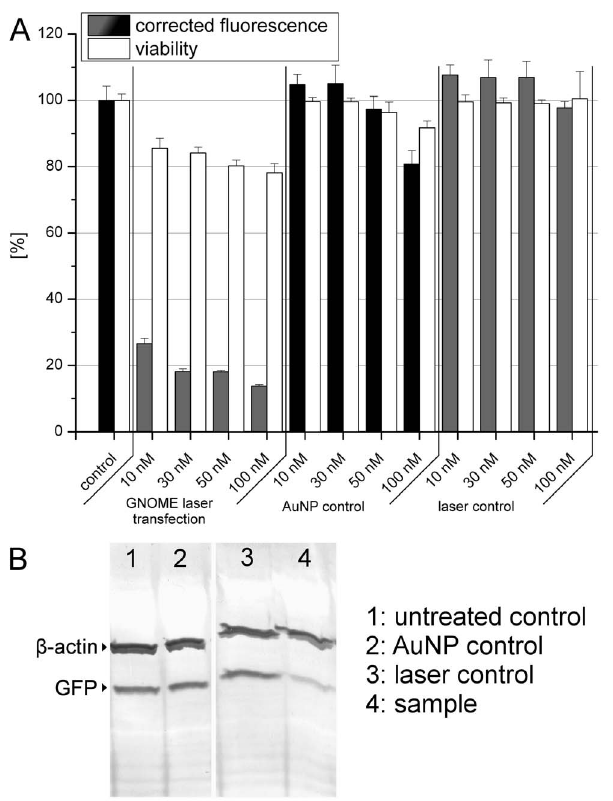
Figure 7. siRNA mediated GFP knock down. A: GFP Fluorescence depletion after GNOME transfection of different siRNA concentrations. No pronounced knock down was observed in the laser and AuNP controls. Values represent the mean of n=3 experiments + SEM. B: Western blot of b -Actin and GFP after siRNA mediated knock down of GFP. The sample shows a 55% reduction in the GFP band intensity.